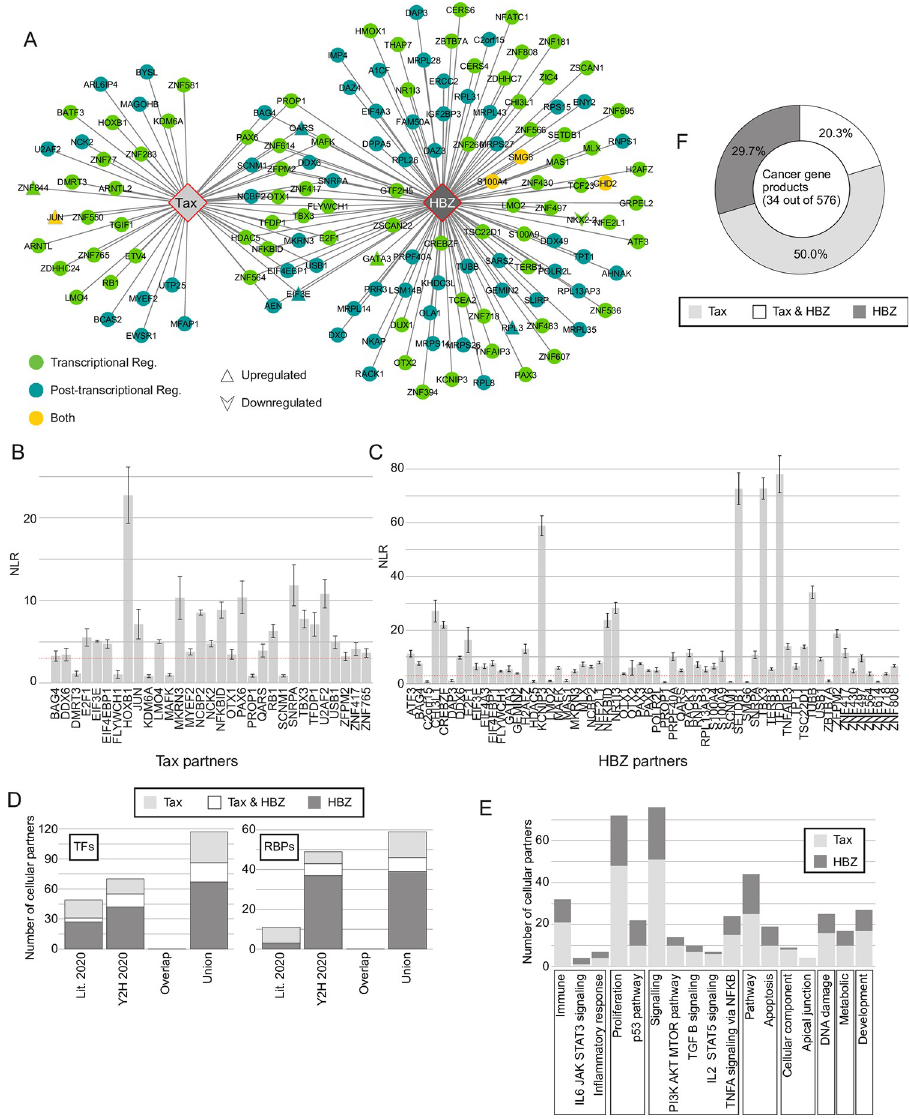
Fig 1. A comparative interactome network of Tax and HBZ with cellular host genes. (A) Y2H Interactome map of Tax and HBZ with host TRs (blue), PTRs (green) or both TR/PTR (yellow). Upward triangles and downward arrows show PPIs for which corresponding genes are upregulated or downregulated following Tax or HBZ expression in Jurkat cells. (B) and (C) GPCA validation assay for Tax (B) or HBZ (C) and their interacting partners identified in Y2H. Y-axis shows normalized luciferase ratios (NLR). Bar graphs represent the mean number ± SD. Positive interactions are indicated by NLRs above dashed red line (D) Graph showing the number of RBPs and TFs interacting with Tax and HBZ in different datasets. “Overlap” means interactions already known in the literature, “Union” means the combined list of interactions from this study and the literature (E) As in (D) but number of coding genes that are parts of a GSEA hallmark category. (F) Percentages of Cancer gene products interacting with Tax and HBZ. See also S1, S2 and S3 Figs and S1